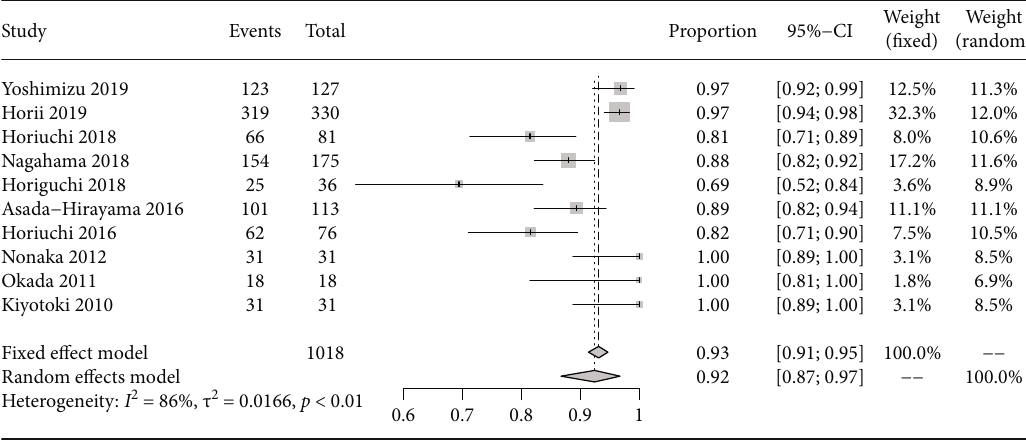
Figure 2: The diagnostic accuracy of magnifying endoscopy with narrow-band imaging for the extent of early gastric cancer. Table 2: Subgroup analysis on diagnostic accuracy of magnifying endoscopy with narrow-band imaging for the extent of early gastric cancer. Study